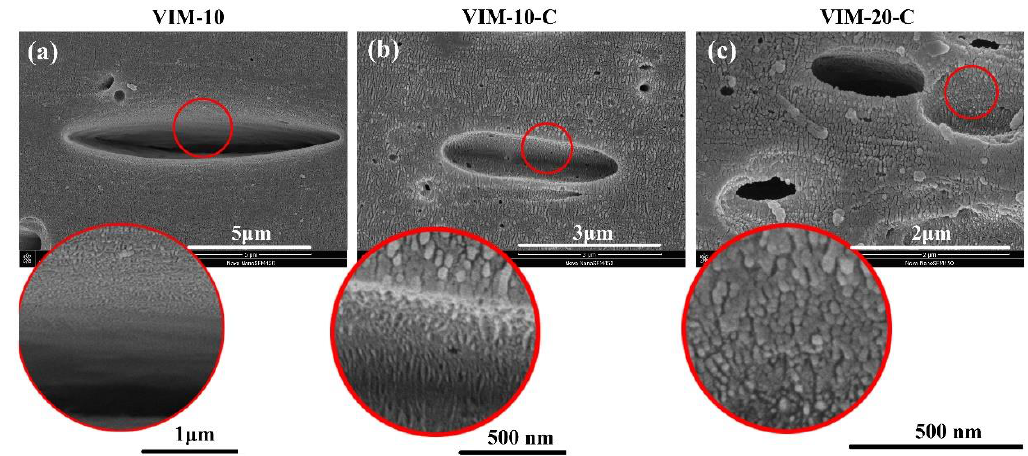
Figure 5. ( a – c ) Crystalline morphology of PP. Red circles are enlarged view of interface.